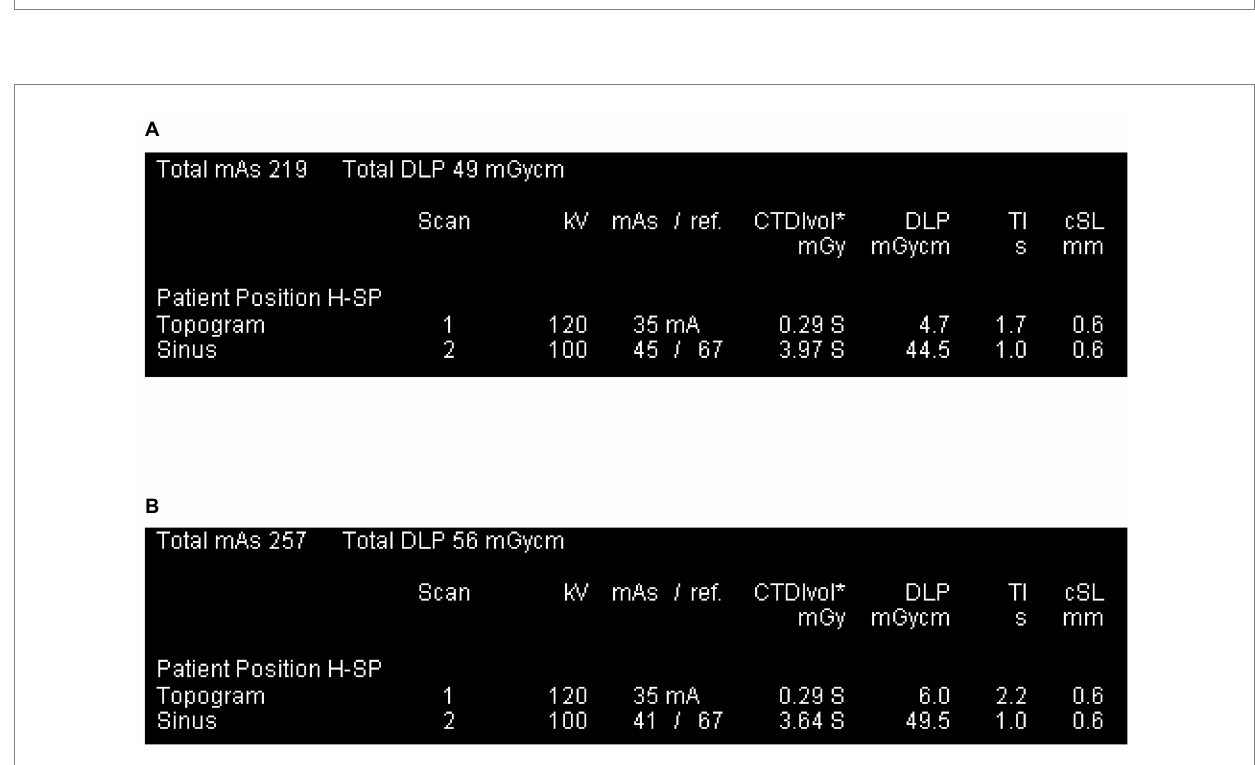
FIGURE 2 Patient protocol. (A) The smallest DLP across all study subjects, was obtained from a 1-year-old child. (B) The largest DLP of all study subjects, was obtained from a 10-year-old